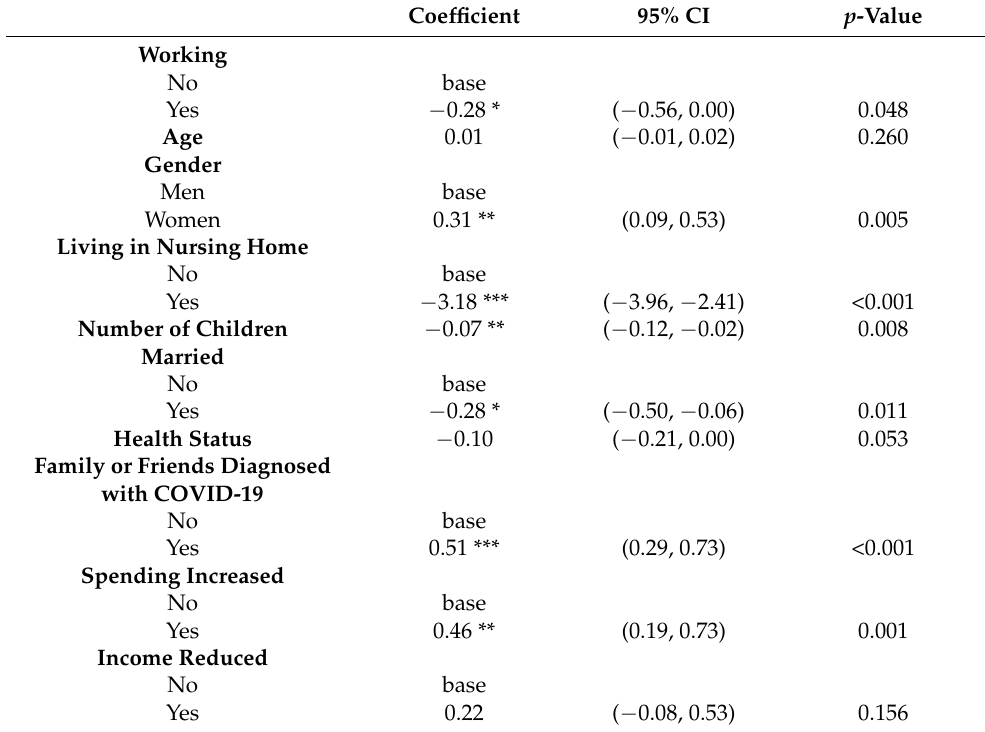
Table 2. Multiple Regression Predicting Participants’ Level of Concern towards